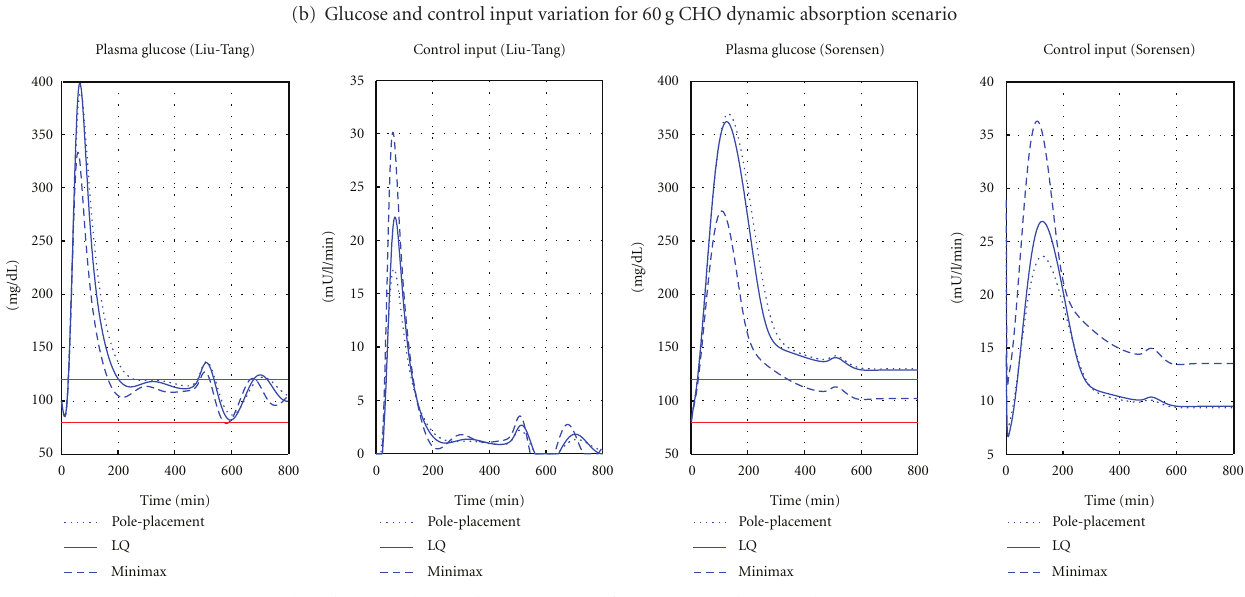
Figure 10: Comparison of pole-placement, LQ, and minimax control methods on the modified Liu-Tang model and modified Sorensen model for the three static absorption scenarios taken into